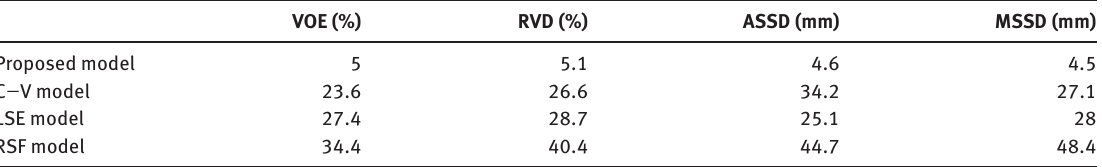
Table 1: Average VOE, RVD, ASSD, and MSSD for the Proposed Models and Existing Algorithm Using CT Scan. VOE (%) RVD (%) ASSD (mm)